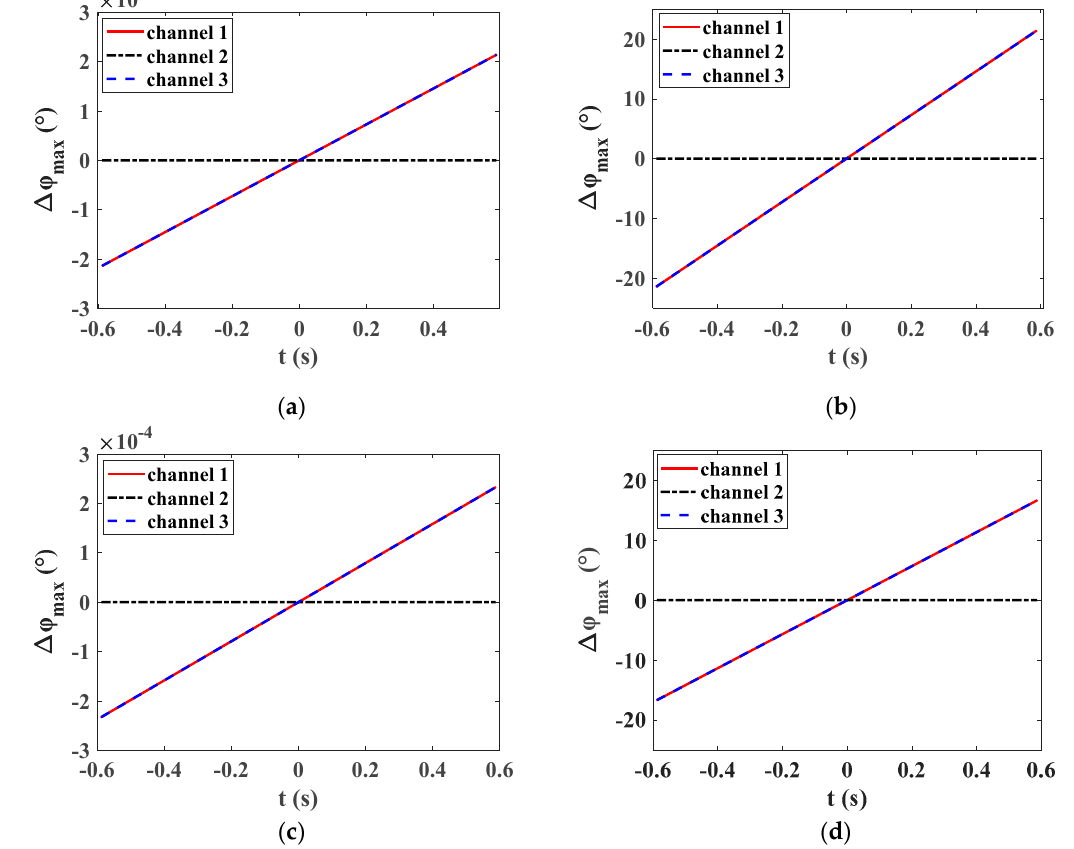
Figure 4. Time-varying phase errors between azimuth channels in different DPCMAB systems. ( a ) In a monostatic system with azimuth aperture intervals of − 10 and 10 m; ( b ) in a distributed satellite system with azimuth aperture intervals of − 1 and 1 km; ( c ) in a monostatic system with azimuth aperture intervals of − 3.33 and 3.33 m; ( d ) in a distributed satellite system with azimuth aperture intervals of 885 and 970 m.